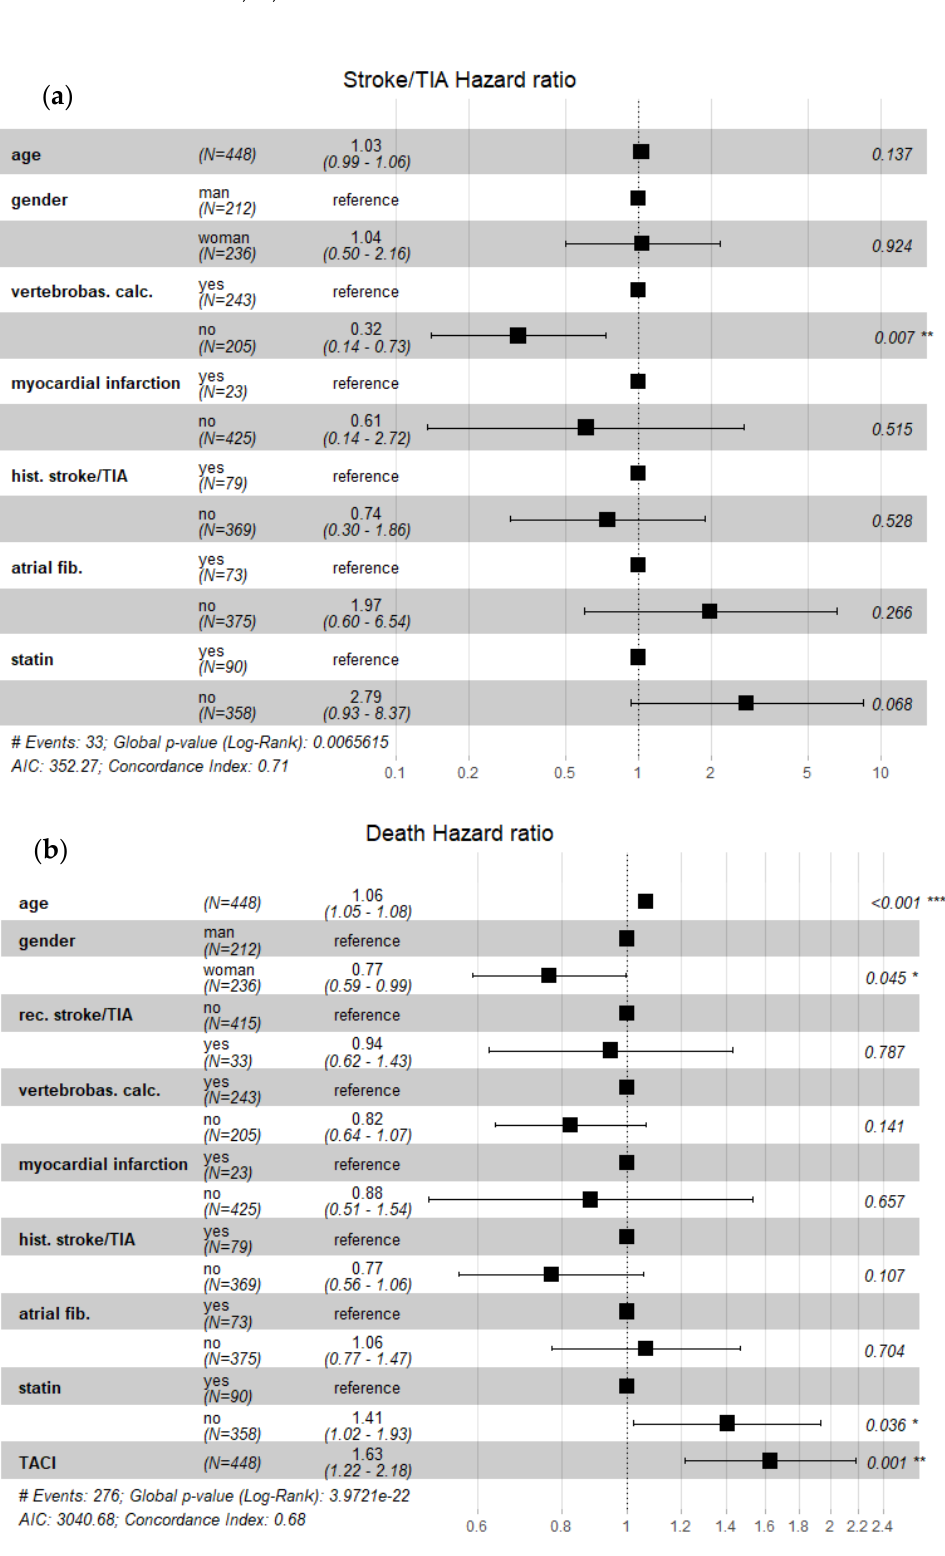
Figure 3. Forrest plots depicting hazard ratios for recurrent stroke / transitory ischemic attack (( a ) Panel A) and death (( b ) Panel B) in population of 448 ischemic stroke patients followed up to 7 years. Legends: vertebrobas. calc.–presence of vertebrobasilar calcifications; TIA–transitory ischemic attack; hist. stroke / TIA–history of stroke and / or TIA; rec. stroke / TIA–recurrent stroke / TIA; atrial fib.–history of atrial fibrillation; TACI–total anterior circulation stroke; and statin–taking statin upon inclusion in the study